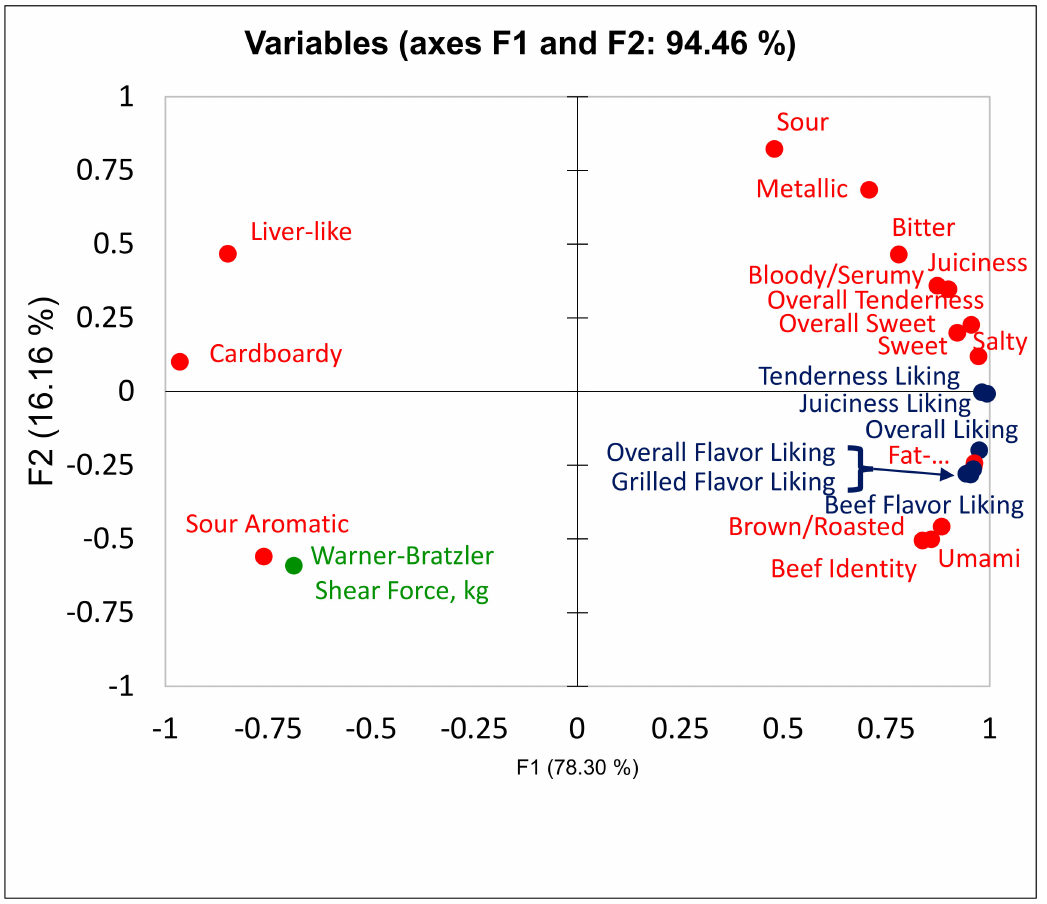
Figure 1. Principal component biplot of data adapted from Laird (2015) [90] and Luckemeyer (2015) [82] where descriptive flavor and texture attributes are in red, Warner-Bratzler shear force (WBSF) values are in green, and consumer sensory attributes are in